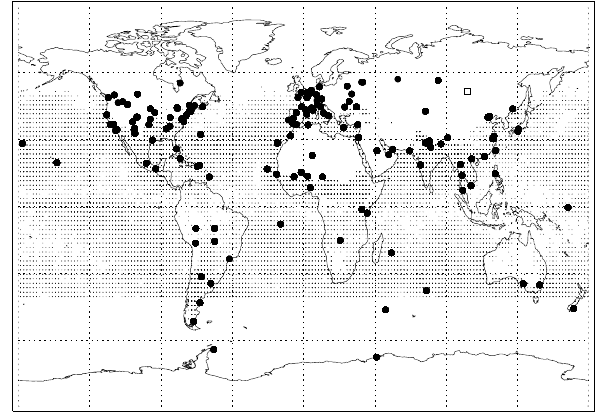
Spatial sampling during January 2009 of MODIS Aqua and